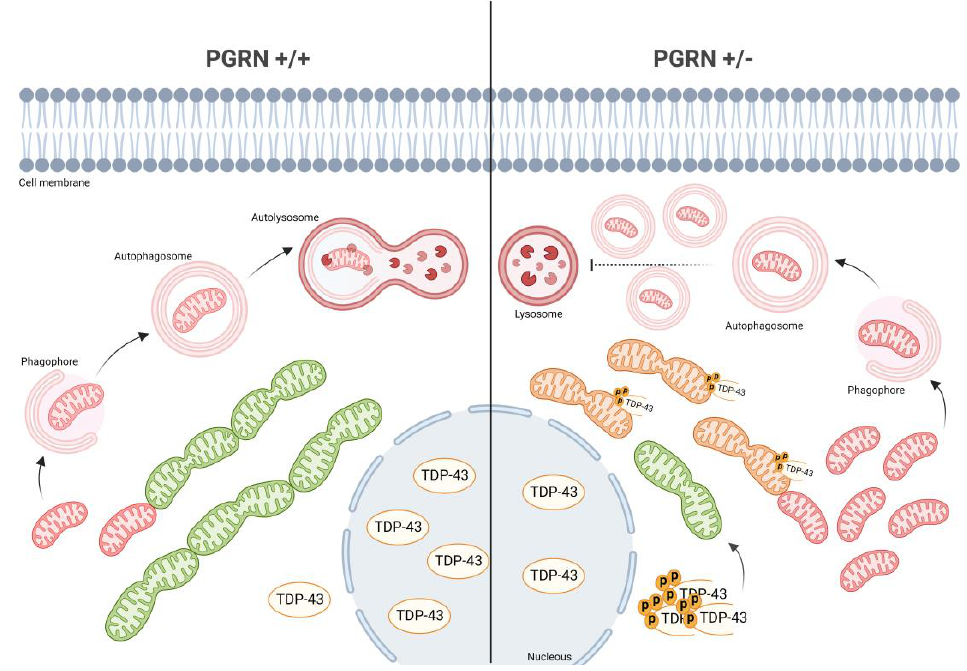
Figure 6. Diagram summarizing the role of PGRN insufficiency in regulating mitochondrial